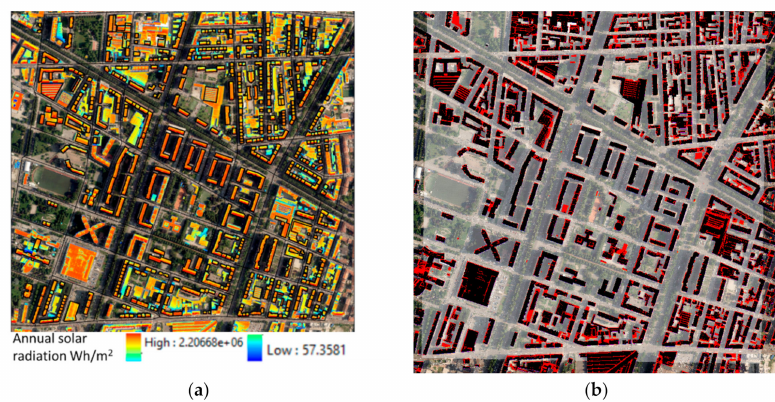
Figure 10. Solar energy technology assessment: ( a ) Annual solar radiation, solar roofs are identified with a black outline; ( b ) identification of areas (in red) with annual solar radiation < 1200 kWh / m 2 (not suitable for solar energy production).